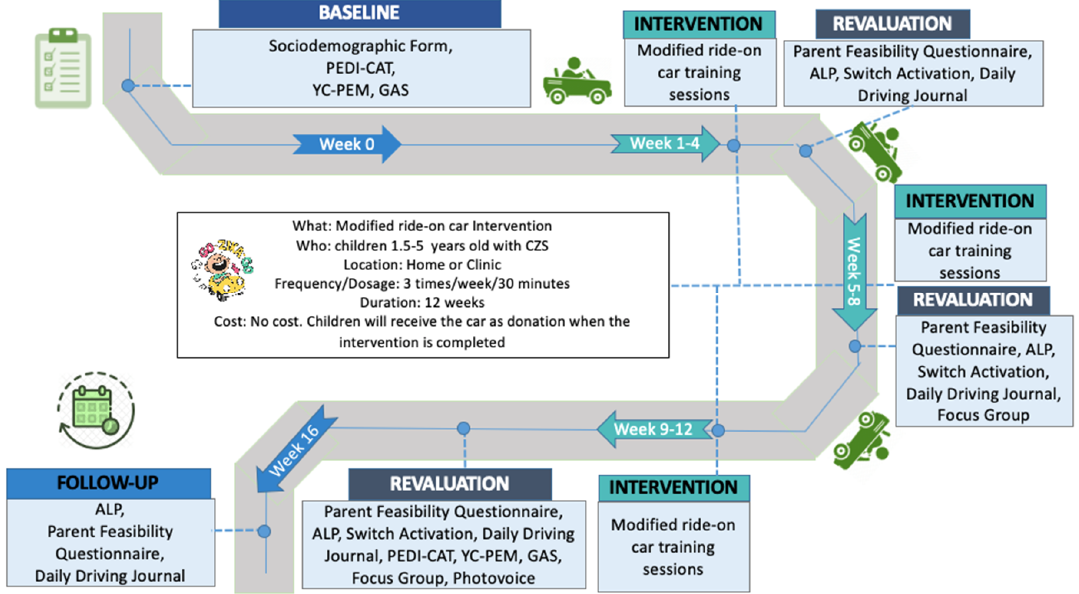
Figure 1. Go Zika Go timeline and procedure intervention for children with congenital Zika syndrome (CZS) between 1.5–5 years age.